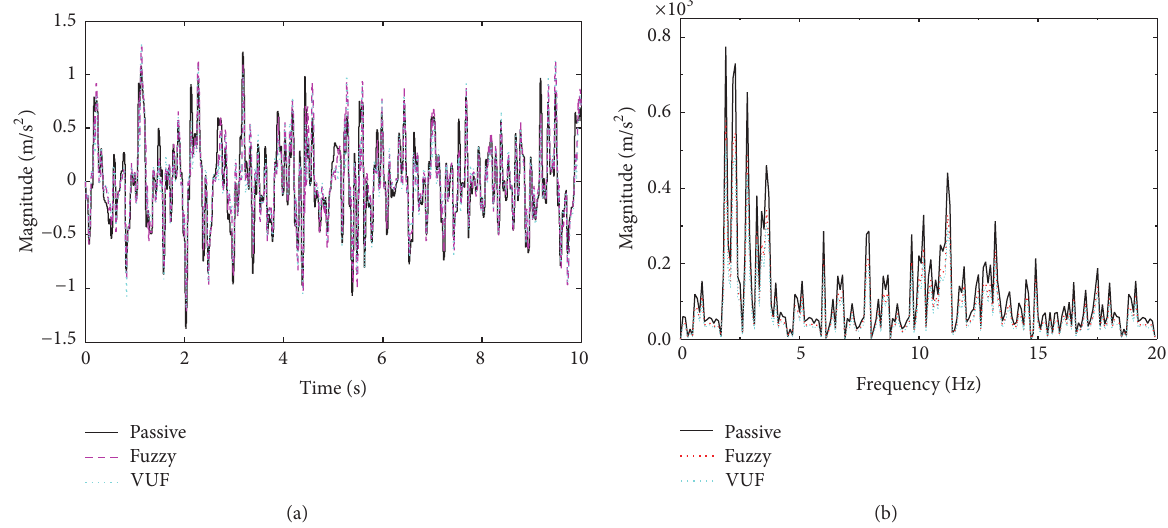
Figure 7: Body acceleration: (a) time domain and (b) frequency domain.